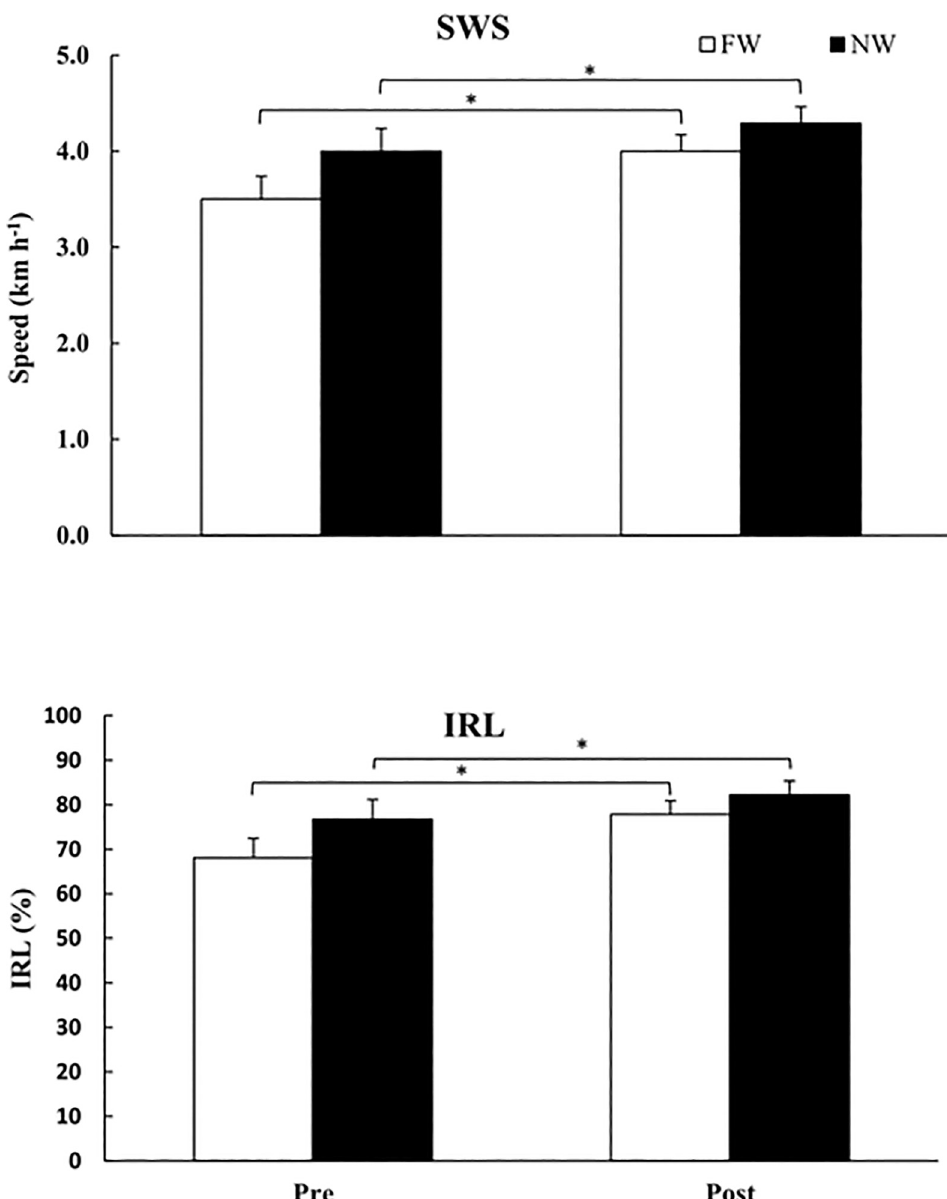
Fig 4. Results of the self-selected walking speed (SWS, top panel) and the locomotor rehabilitation index (LRI, bottom panel). Free walking group (FW, white column) and Nordic walking group (NW, black column) in pre- and post-training moments. Mean and standard errors. � Symbols represent significant differences in time factor ( p = 0.011 and p = 0.013, respectively).